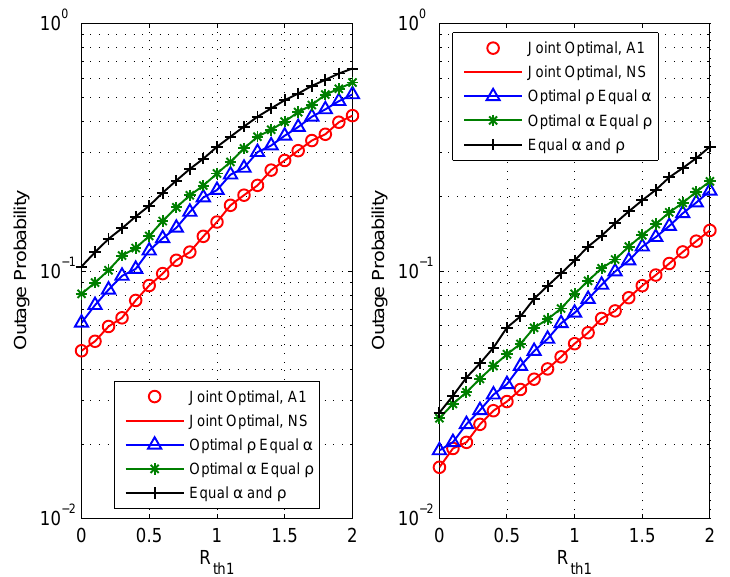
Figure 4. Comparison of outage performance vs. the rate threshold R th1 of different schemes: ( a ) P t = 15 dBm (the left figure); ( b ) P t = 20 dBm (the right